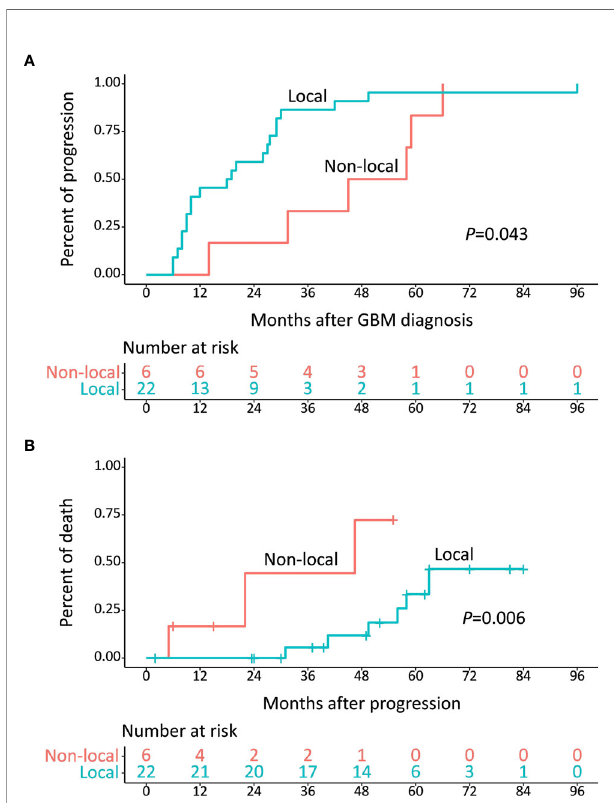
FIGURE 4 | (A) Median time from diagnosis to development of progression was 18.5 months for local recurrence and 45.0 months for non-local recurrence ( P = 0.043). (B) Median survival after diagnosis of non-local recurrence was 46.5 months, which was shorter than that of local recurrence ( P =